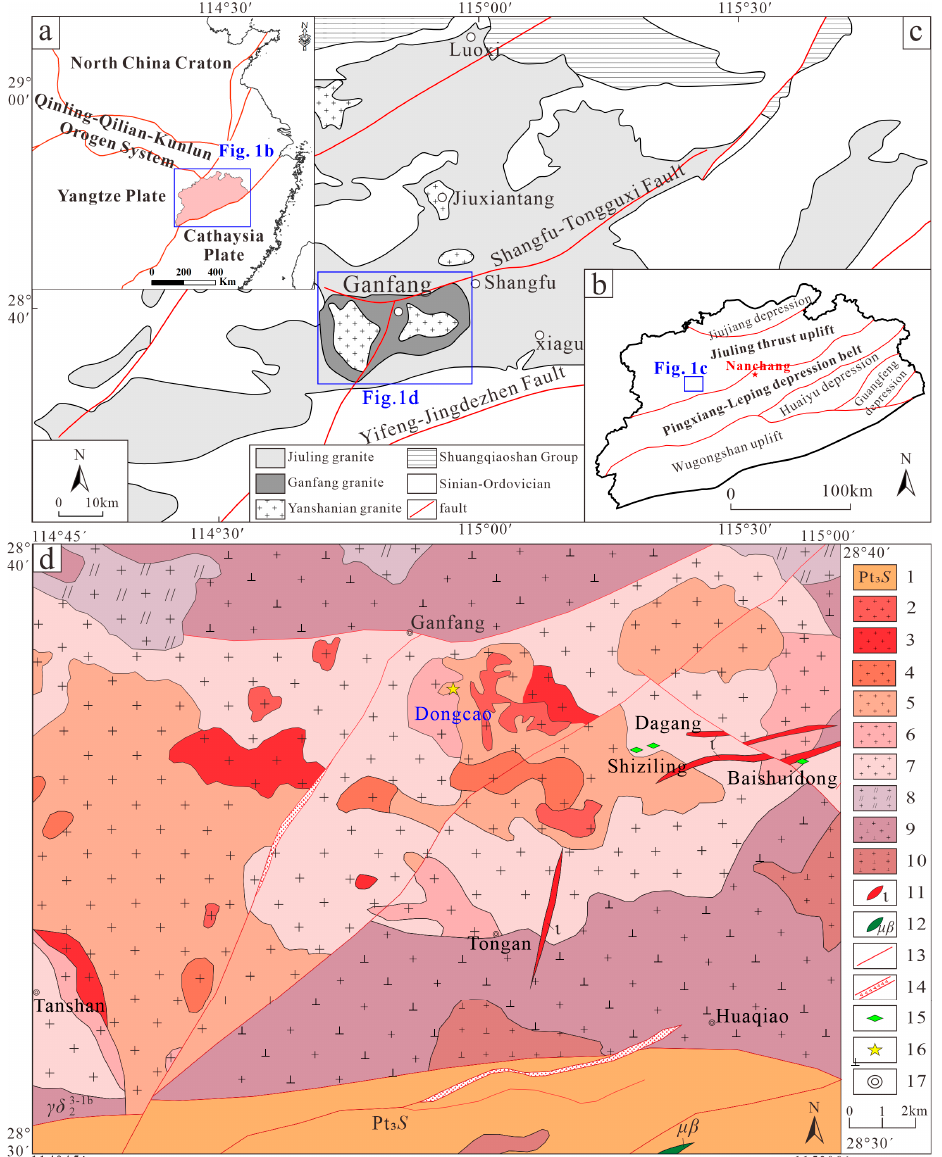
Figure 1. Geological map of the study area: ( a ). geotectonic sketch map of Eastern China (modi fi ed from [16]); ( b ). tectonic schematic map of the study area (modi fi ed from [17]); ( c ). structural map of the study area (modi fi ed from [9]); ( d ). geological sketch map of the study area (modi fi ed from [12]). (Legend description of ( d ): 1. Upper Proterozoic Shuangqiaoshan Group; 2. fi rst stage of Late Yanshanian intrusive granite; 3. third intrusive granite in the second stage of the Early Yanshanian; 4. second intrusion of granite in the second stage of the Early Yanshanian; 5. fi rst granite intrusion in the second stage of the Early Yanshanian; 6. second intrusion of granite in the fi rst stage of the Early Yanshanian; 7. fi rst intrusion of granite in the fi rst stage of the Early Yanshanian; 8. fi rst intru- sion of monzogranite in the second stage of the Late Jinningian; 9. second intrusion of granodiorite in the fi rst stage of the Late Jinningian; 10. the fi rst intrusion of diorite porphyry in the fi rst stage of the Late Jinningian; 11. aplite/felsite; 12. spilite basalt; 13. crushing zone; 14. fault structure; 15. Li − bearing porcelain ore deposit; 16. sampling location; 17. township).